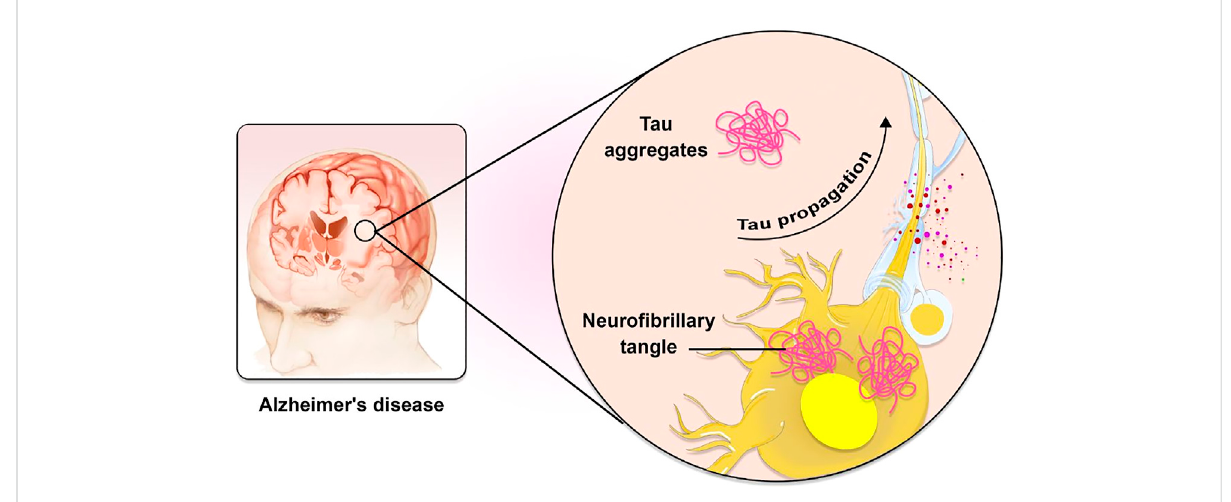
FIGURE 1 The role of Tau in AD pathogenesis. Tau is known to spread in a predictable way along neuronal networks in neuro fi brillary tangles (NFTs). It is possible that the characteristic development of AD neuropathology is caused by interneuron transfer of the pathogenic form of